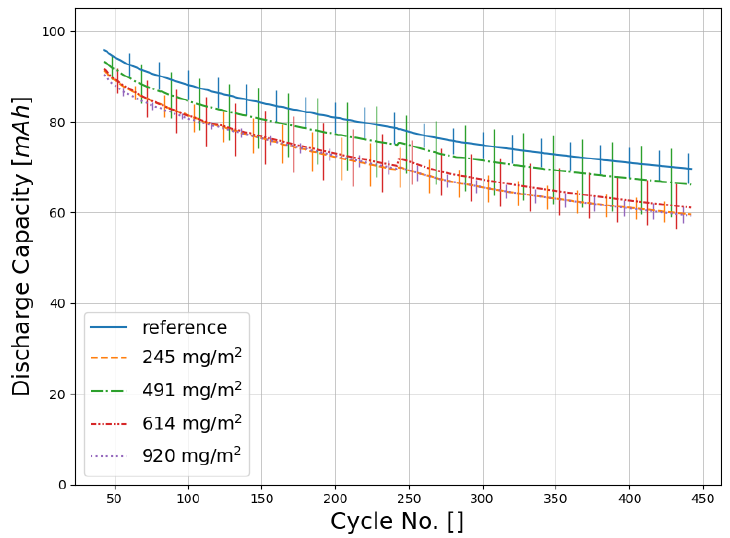
Figure 9. Results of 1 C cycling tests on cells with PE separator. Varying polymer loading, laminated at harsh conditions of 100 °C and 12